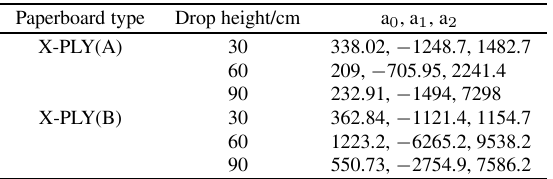
Table 1 Characteristic coef fi cients of dynamic cushioning